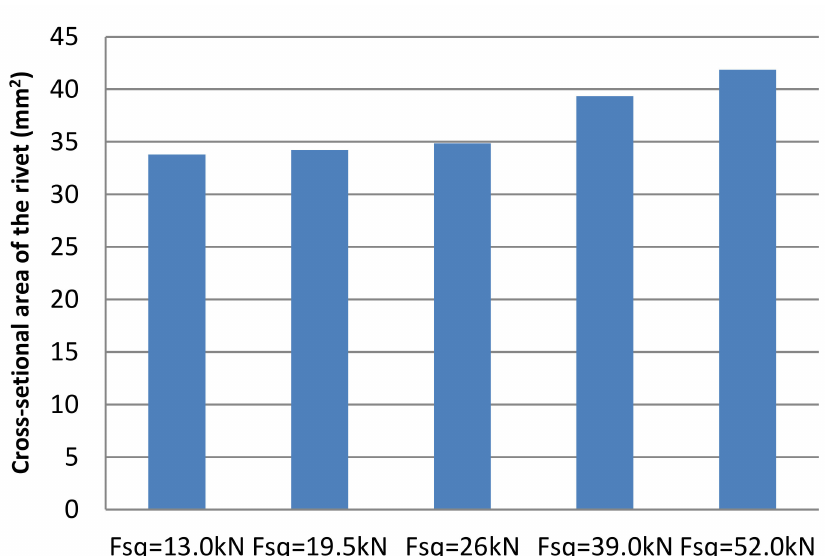
Figure 12. Difference in cross-sectional area of rivet shank with respect to squeezing force.